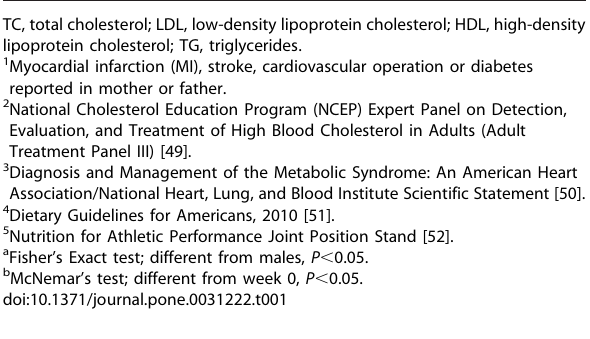
2 National Cholesterol Education Program (NCEP) Expert Panel on Detection, Evaluation, and Treatment of High Blood Cholesterol in Adults (Adult Treatment Panel III) [49]. 3 Diagnosis and Management of the Metabolic Syndrome: An American